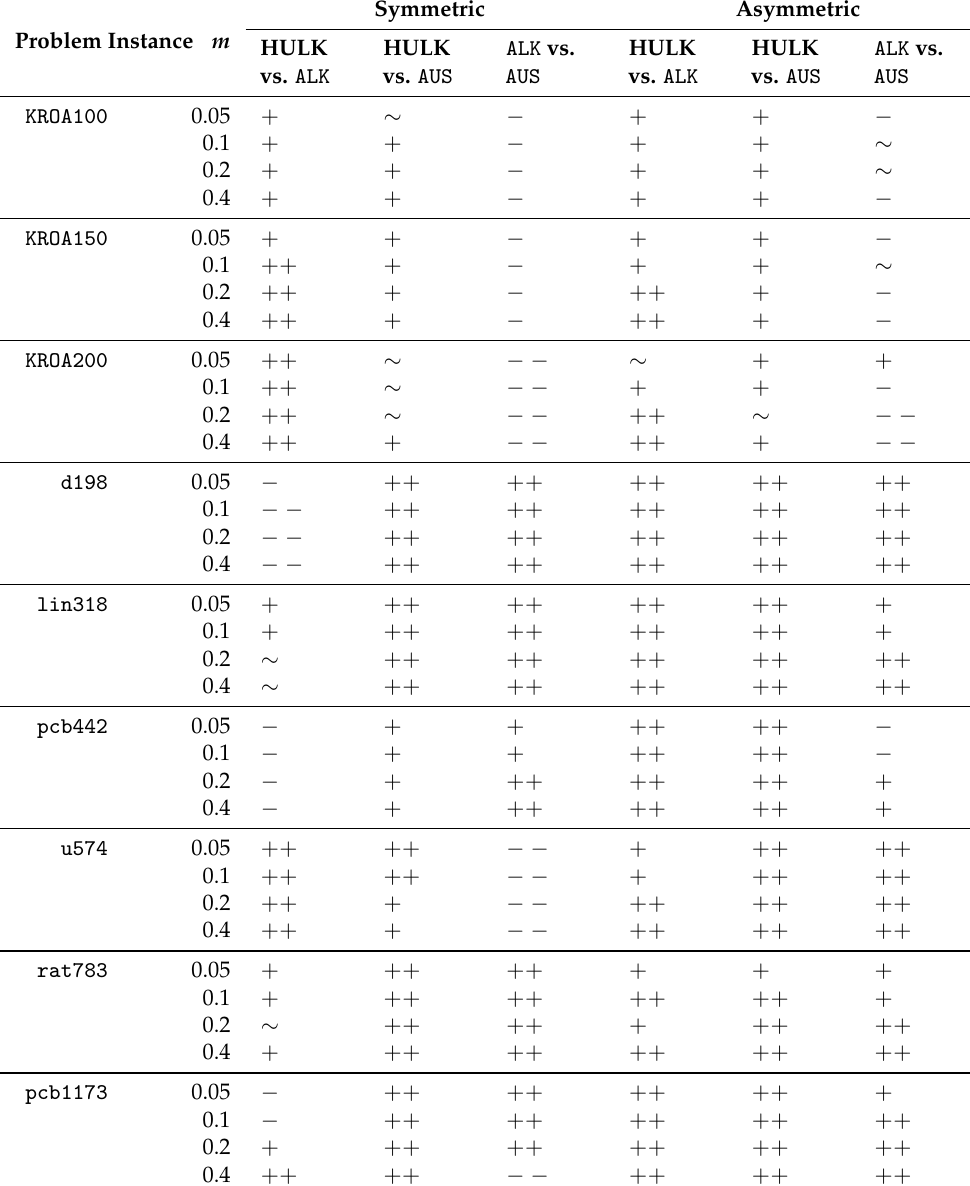
Table 5. Statistical results regarding the average offline performance of the presented methods on symmetric DTSPs (upper half) and asymmetric DTSPs (lower half), where MM AS + LK and MM AS + US are replaced by ALK and AUS ,